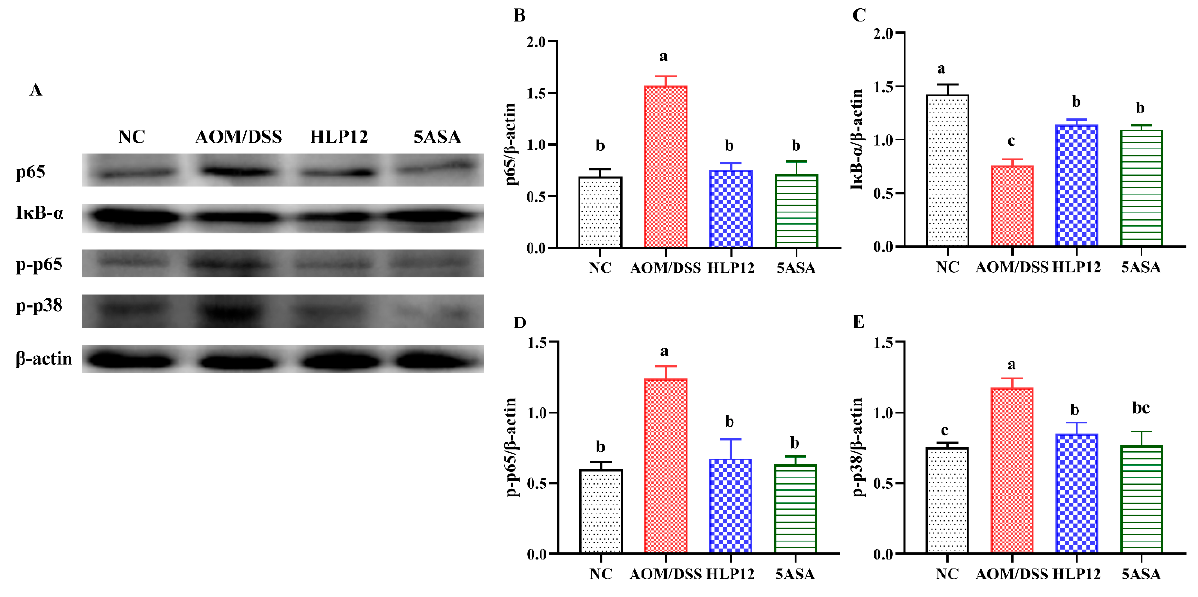
Figure 5. Effect of L. plantarum -12 oral administration on the protein expression related to p38 MAPK and NF- κ B signaling pathways of the AOM/DSS-treated C57BL/6 mice. ( A – E ) p65, I κ B- α , p-p65, and p-p38 in the colon of AOM/DSS-treated mice were assessed by Western blotting ( n = 4). The data with different lowercase letters are significantly different ( p < 0.05).